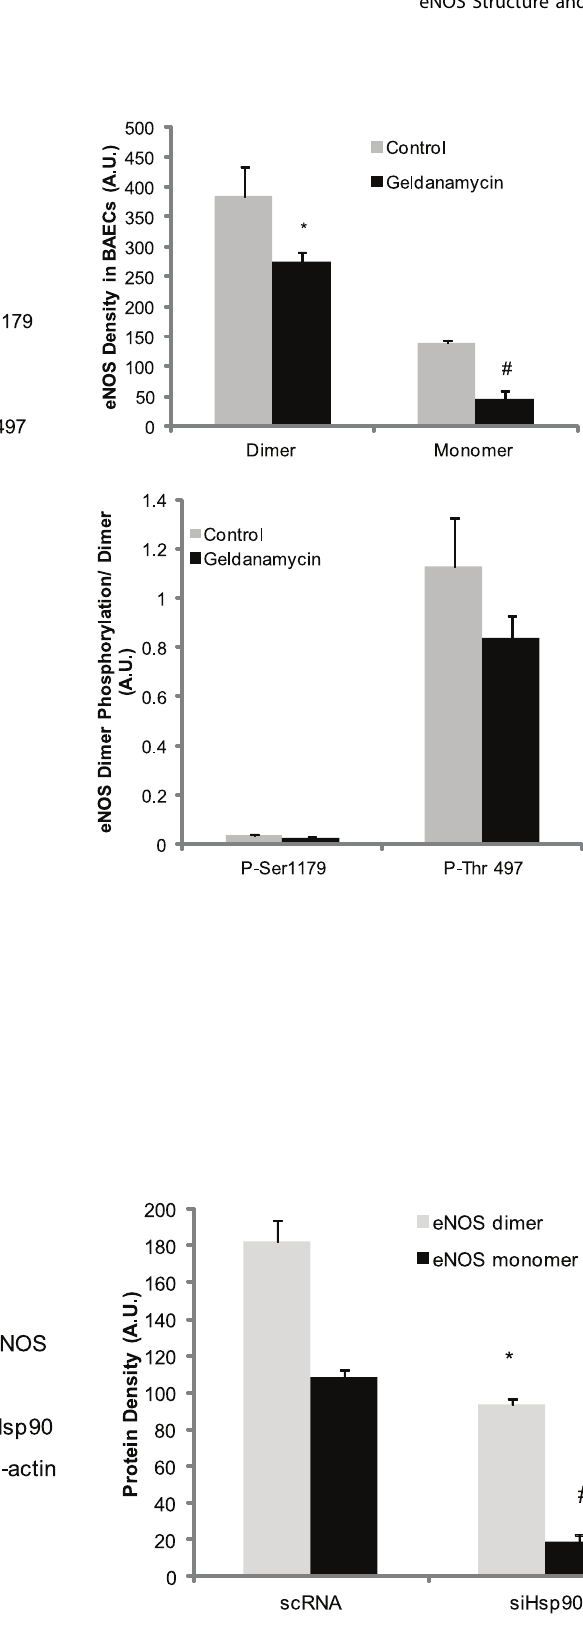
Figure 6. Inhibition of Hsp90 resulted in eNOS monomerization without change phosphorylation status of Serine 1179 and Threonine 497 in eNOS dimmer. (A) BAECs were treated with 20 m M geldanamycin for 48 hours and the samples were run SDS-PAGE gel at low temperature and blotted with the indicated antibodies to determine the changes in phosphorylation status of eNOS and dimers and monomers. The eNOS dimer and monomer densities were determined using AlphaImager. And The Ser1179 and Thr497 phosphorylation density on eNOS dimer